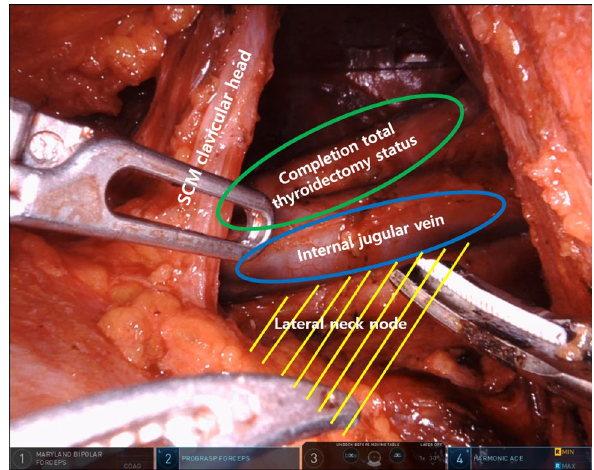
Figure 3. Modified radical neck node dissection robotic view. The patient was performed left side approach robotic left total thyroidectomy with central compartment neck node dissection previously. Re-do operation (completion total thyroidectomy and modified radical neck node dissection) using robotic system for left lateral neck node recurrence was performed. Abbreviations: SCM sternocleidomastoid